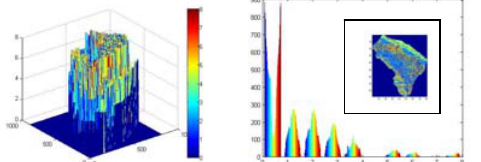
Figure 7: Land use/Land cover classification from remote sensing images